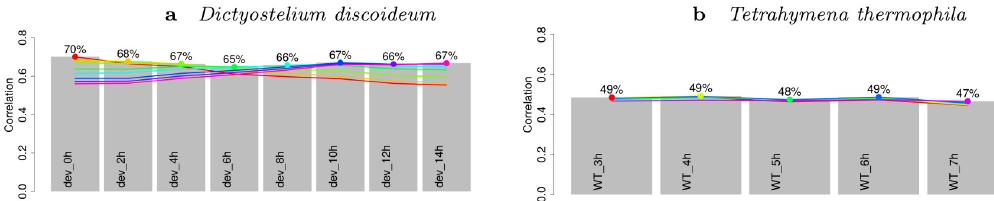
Fig 9. DExTER accuracy on D . discoideum and T . thermophila , two other genomes with high AT content. Grey charts represent the accuracy (y-axes), measured as the correlation between predicted and observed gene expression, of the models learned on different conditions (x-axes). Colored curves summarize the accuracy of a model learned on a specific condition (identified by a big dot of the same color) when used to predict the other conditions of the series.